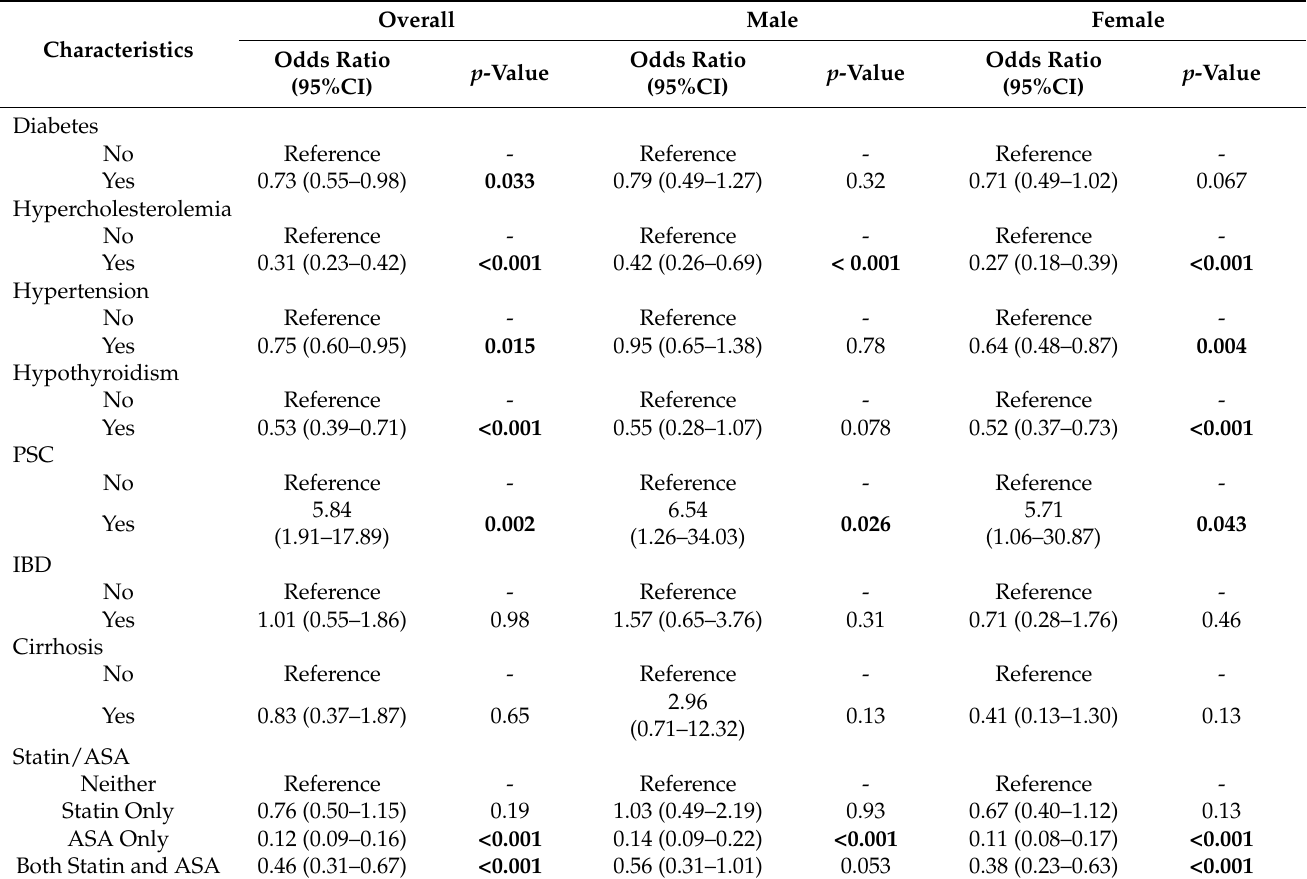
Table 3. Multivariable analysis of factors evaluated for an association with having gallbladder cancer identified at diagnosis, overall and stratified by